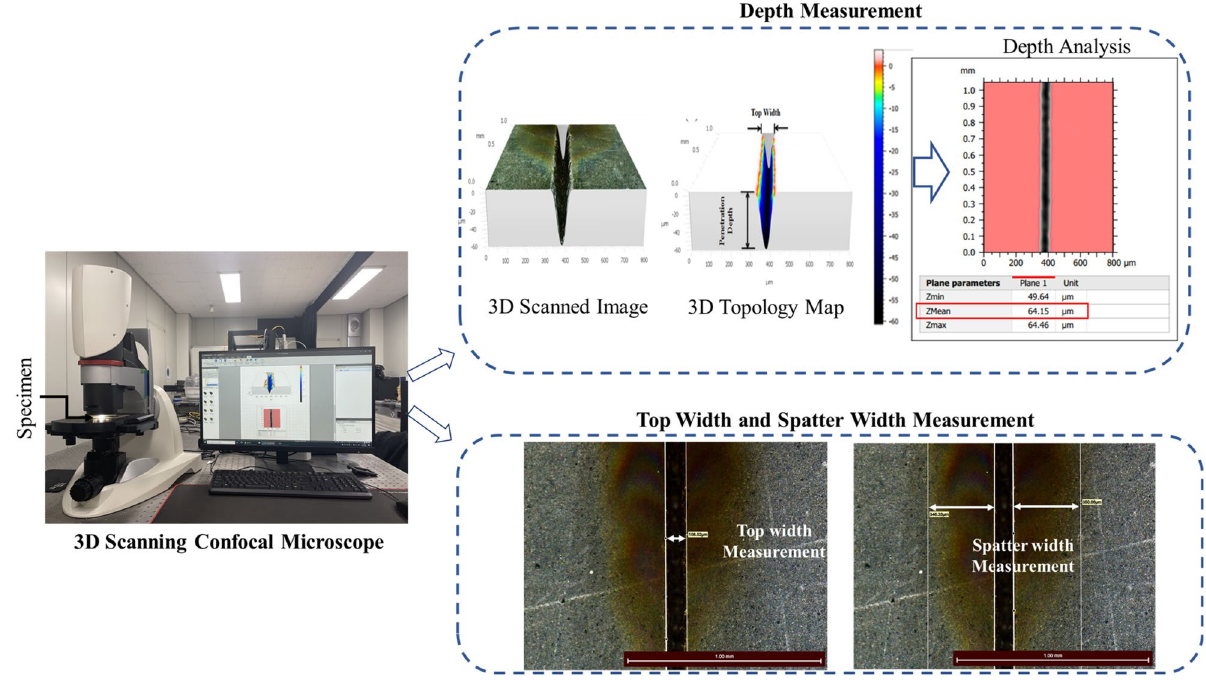
Figure 5. Measuring device and measurement